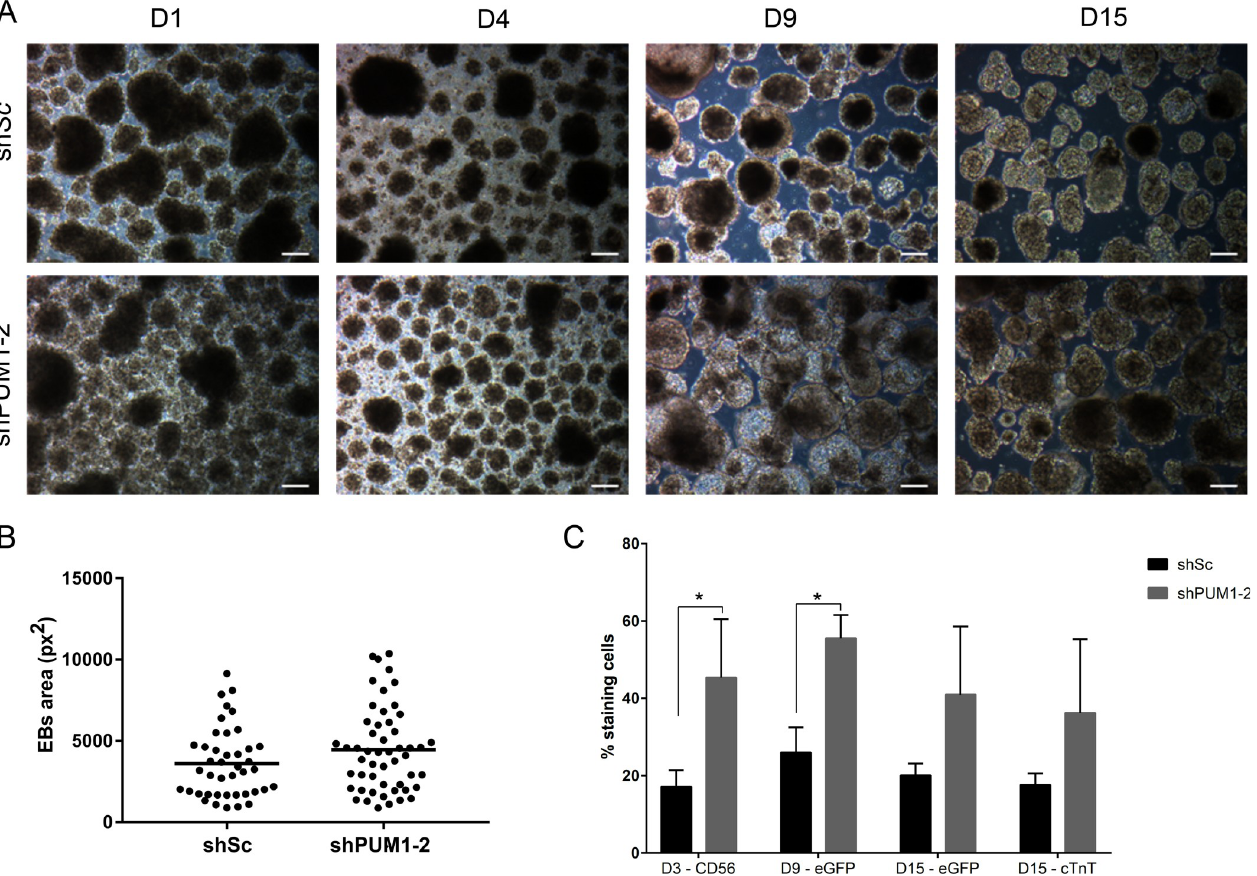
Fig 3. Effect of the knockdown of PUM1 and PUM2 during EB cardiac differentiation. (A) Morphology of EBs at days 1 (D1), 4 (D4), 9 (D9) and 15 (D15) of the cardiomyogenic differentiation of hESCs previously transduced with shSc and sh PUM1-2 . Scale bars: 100 μ m. (B) Area of EBs after 9 days of in vitro cardiac differentiation (the measurements were performed manually using ImageJ software) (n = 3). (C) Percentage of cells transduced with shSc and sh PUM1- 2 that were positive for CD56, eGFP/ NKX2 . 5 and cTnT during cardiomyogenesis (n = 3). � p <